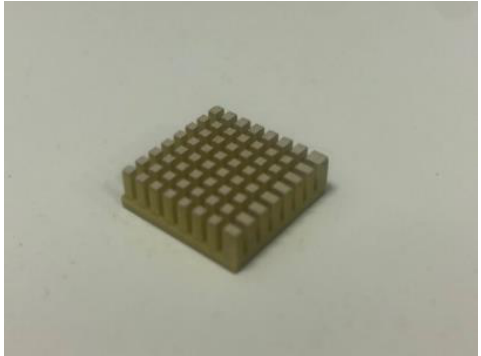
Figure 1. The skeleton of the specimen.